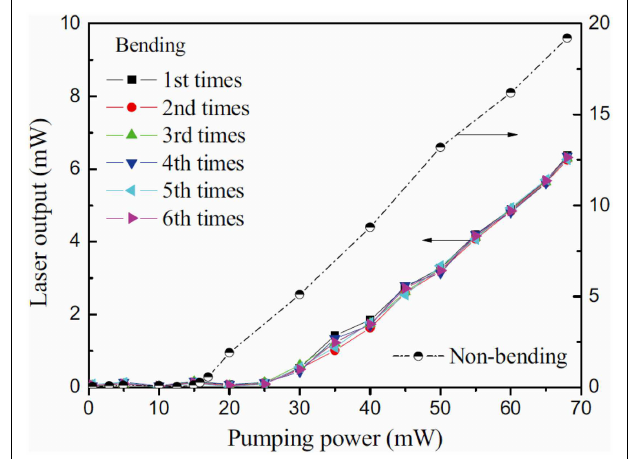
FIGURE 21 |Variation of the laser output with the pumping power inputted into the PbSe QD-doped fiber (Cheng et al., 2013)